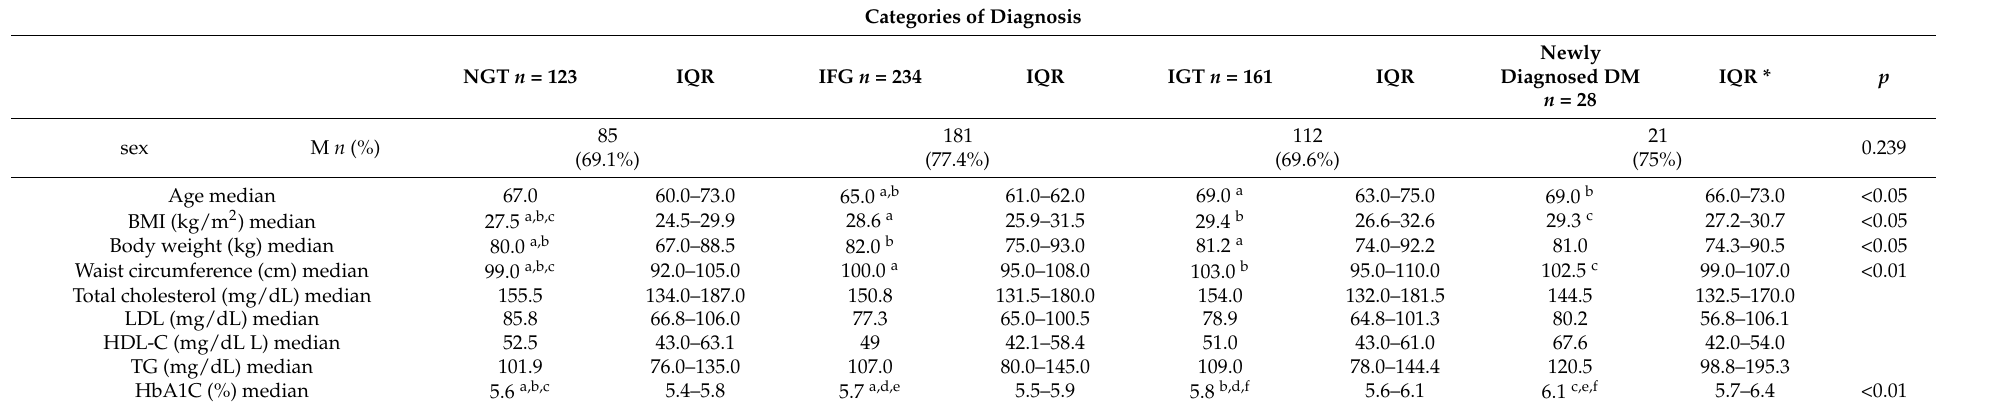
Table 2. Patients’ characteristics by glucose category in group with OGTT.